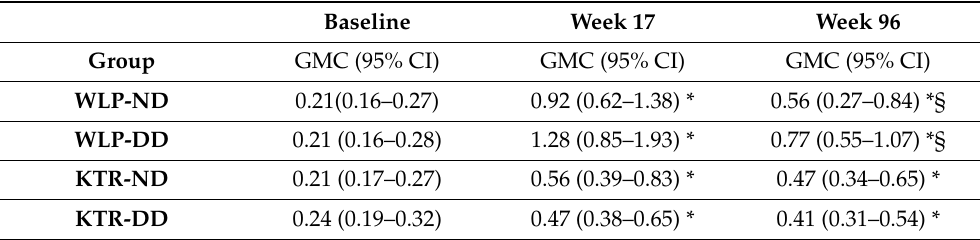
Table 3. Average pneumococcal antibody geometric mean concentrations with 95% confidence intervals at baseline, 17 weeks, and 96 weeks (mg/L).